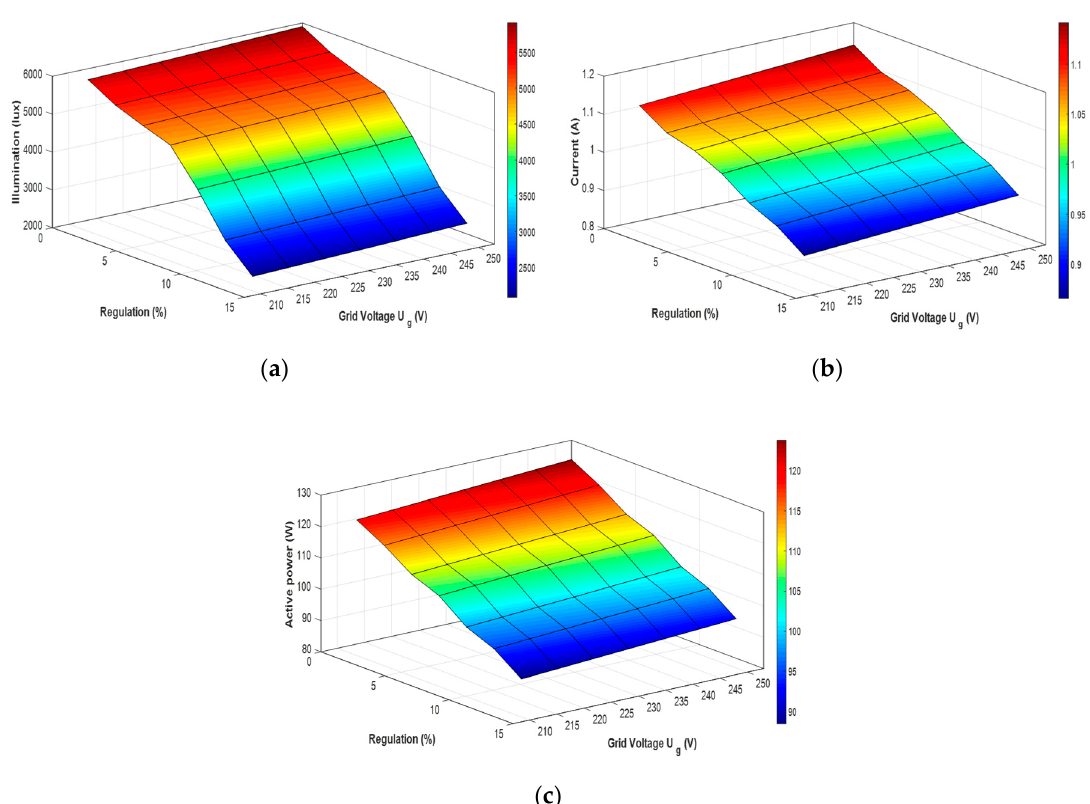
Figure 14. SON Lamp regulation: ( a ) Illumination; ( b ) Current; ( c ) Active power.